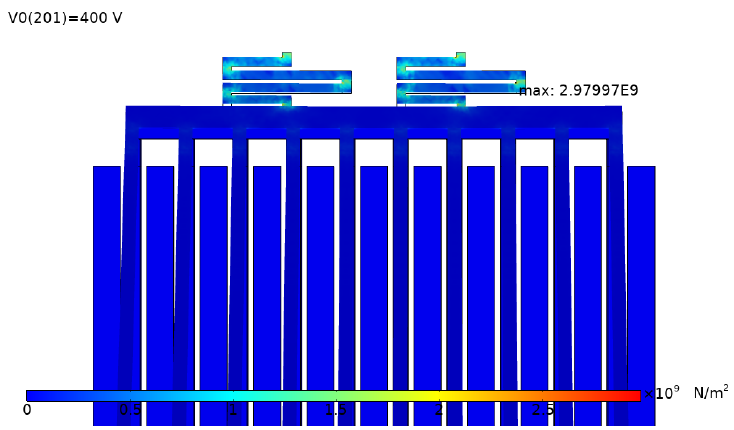
Figure 15. Contour plot of displacement along the z -axis. Table 2. Mechanical properties of single-crystal silicon.